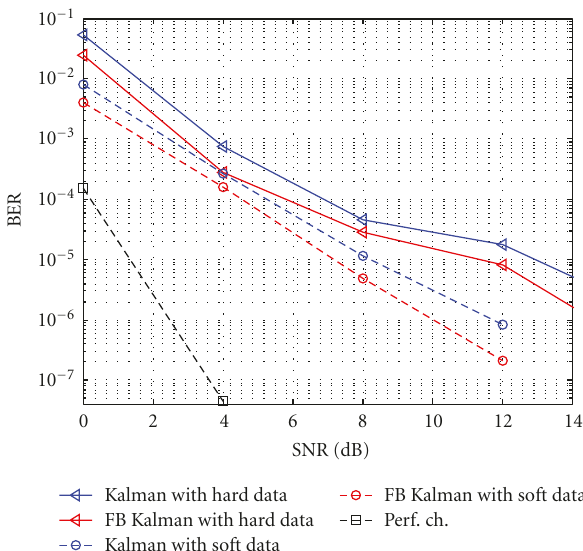
Figure 8: BER performance of Kalman and FB -Kalman using hard and soft estimate of data.